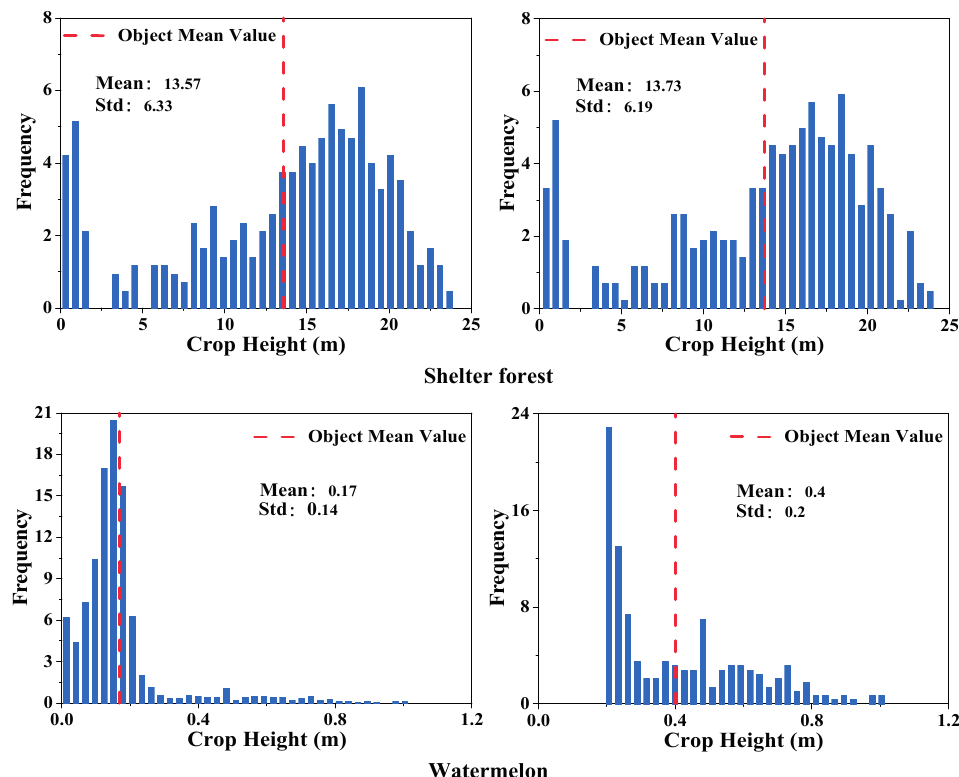
Figure 7. The frequency distributions and the means of the CHM value of image objects before and after pre-processing. ( Left ): before pre-processing; ( Right ): after pre-processing. The red dotted lines show the mean values of their corresponding CHM image objects.